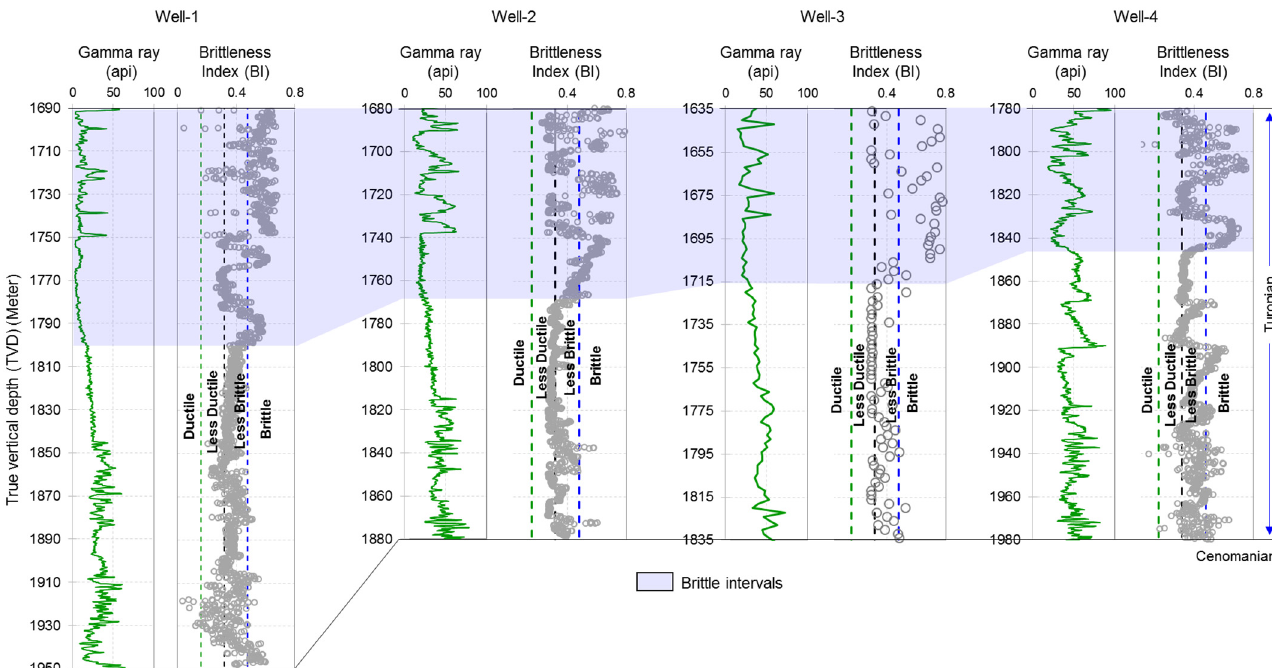
Figure 6. Estimated BI of the studied Turonian carbonates in the four studied wells indicating higher brittleness in the top of the Turonian interval.